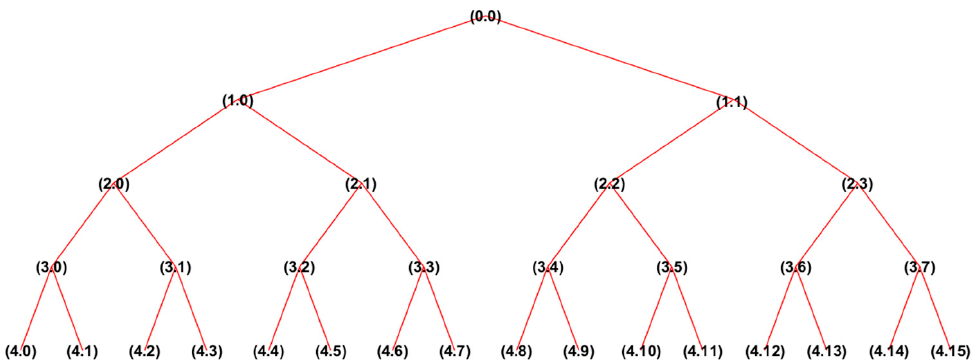
Figure 4. Structure of four-layer WPD.